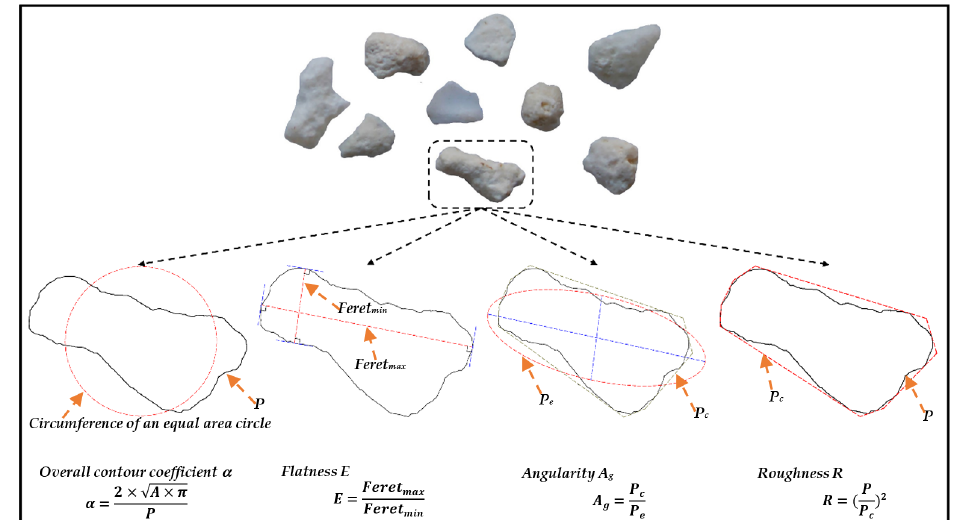
Figure 9. Diagram of the particle shape parameters.